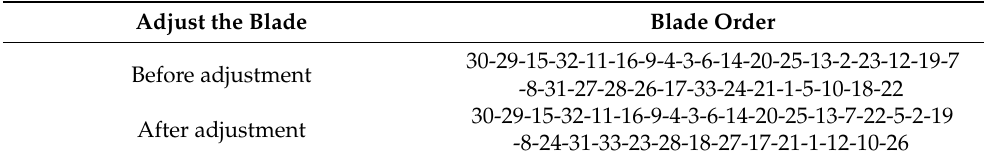
Table 4. Order of blade